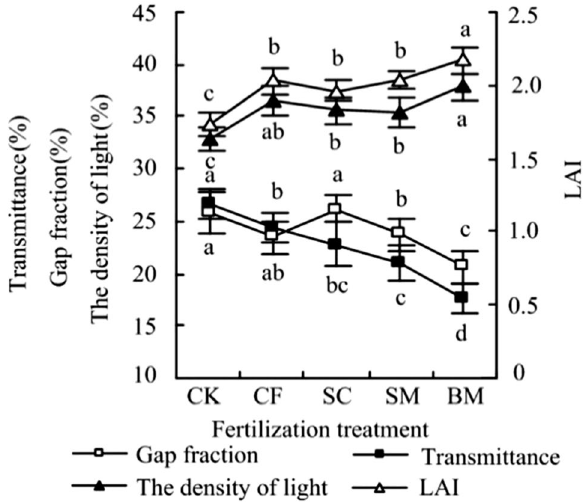
Figure 3. Effects of different fertilizer treatments on canopy characteristics of Pear-jujube. Note : Note: At different levels, each population mean follows a normal distribution with the same variance. The least significant difference (LSD) method was selected for analysis of variance in DPS software. Different lowercase letters indicate a significant difference between treatments ( P < 0.05).